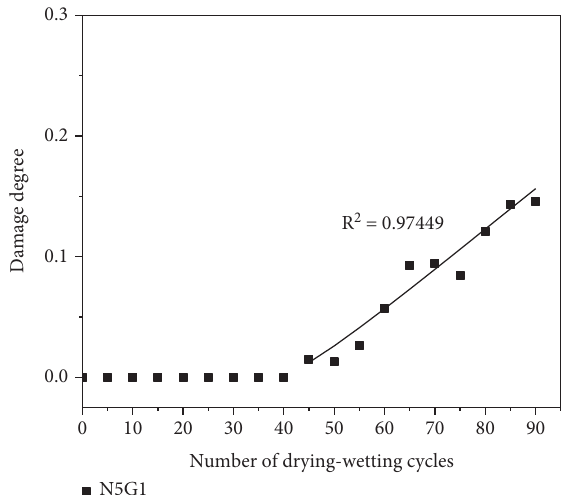
Figure 9: Variation of the damage degree of concrete under 5% Na